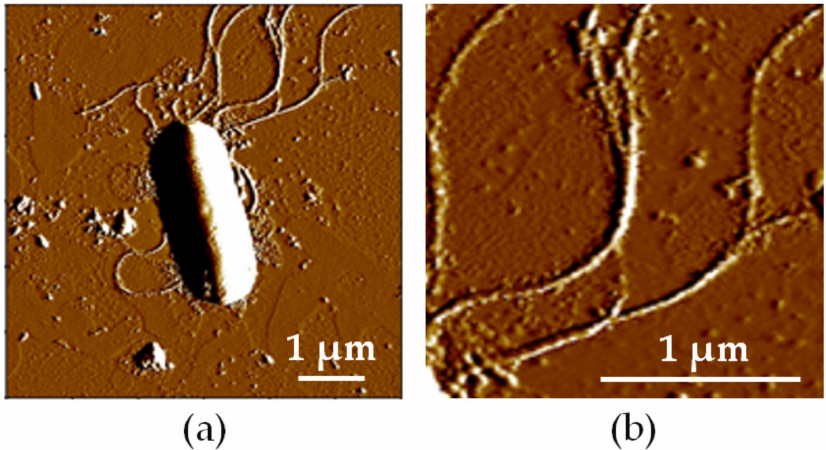
Figure 2. ( a ) 6 × 6 µ m 2 and ( b ) 2 × 2 µ m 2 large atomic force microscopy (AFM) image of a